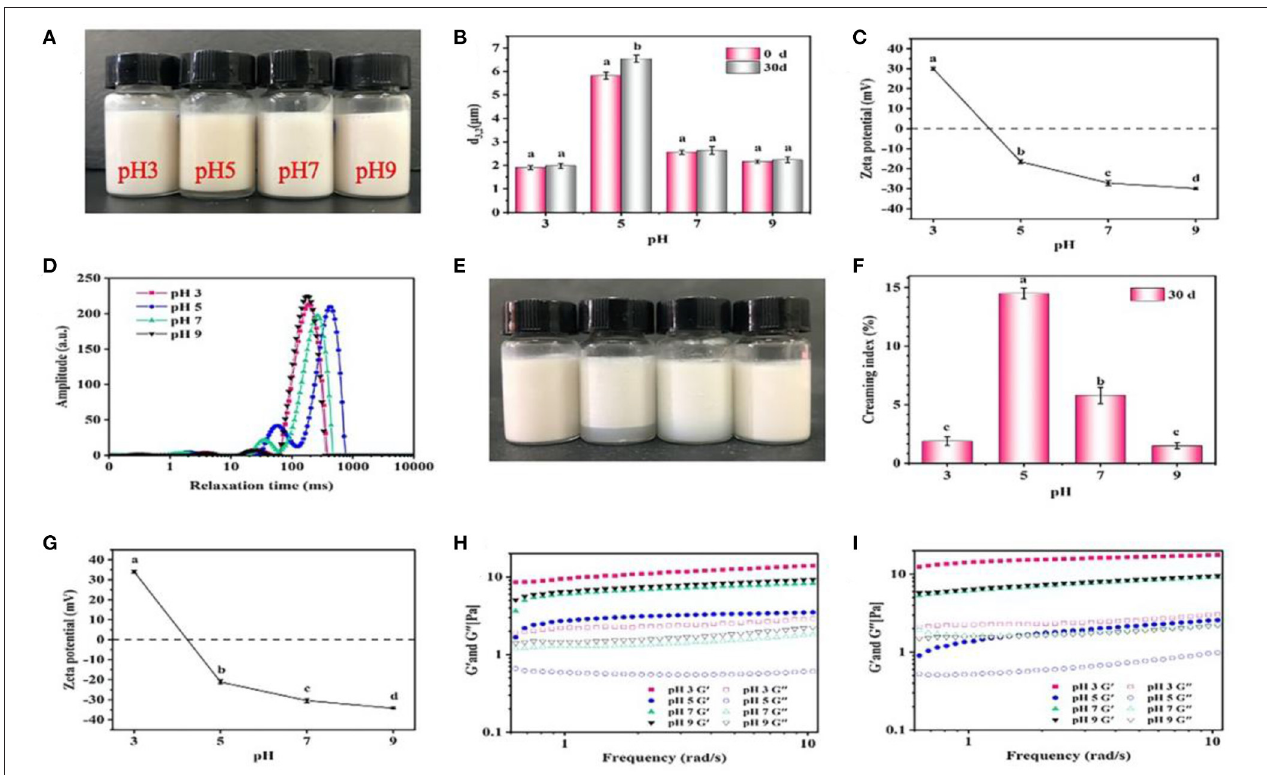
FIGURE 6 | Effects of pH on the visual appearance (A,E) , droplet size (B) , ζ -potential (C,G) , LF-NMR (D) , creaming index (F) , and rheological properties (H,I) of the emulsions prepared by 2% proteins and 3:7 oil/water ratio after 0 and 30 days storage. Mean values followed by different letters are significantly different ( P < 0.05).